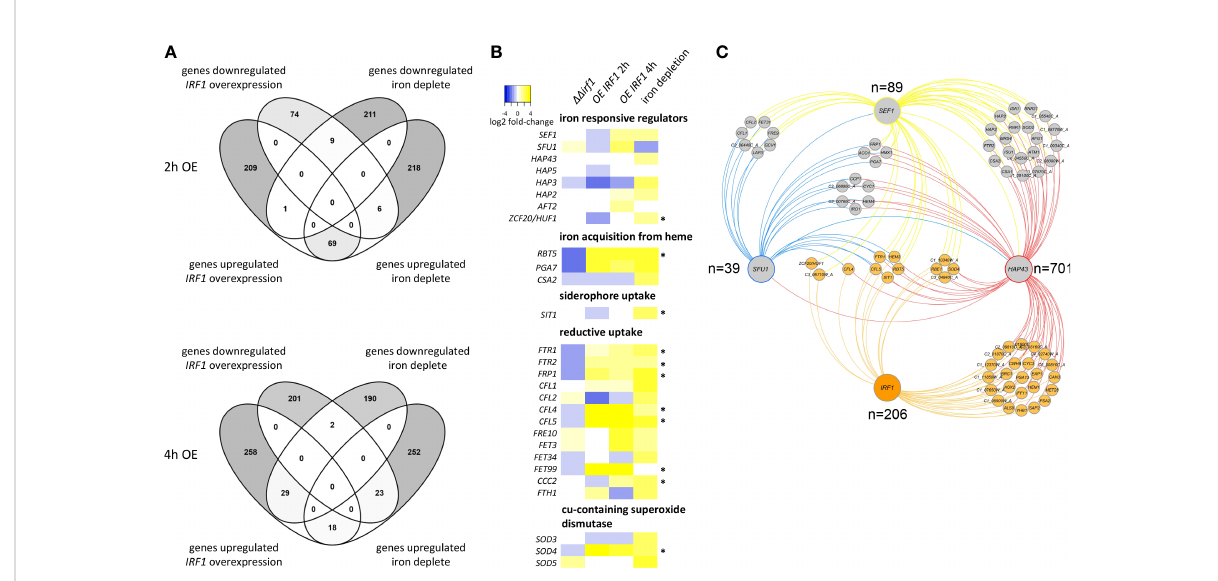
FIGURE 4 Comparative analysis of the IRF1 transcriptome with the iron de fi ciency transcriptome. (A) Transcriptome data of C . albicans cells incubated under iron de fi ciency were taken from Lan et al. (2004) and compared with the transcriptome data of C. albicans overexpressing IRF1 after 2 hours (upper panel) and after 4 hours (lower panel). (B) Heatmap of expression differences (log2 fold-changes) of genes involved in iron homeostasis. (* indicates that the gene is a direct target of Irf1). (C) Interaction network of transcriptional regulators involved in maintaining iron homeostasis. The corresponding target genes of the respective transcription factors were obtained from pathoyeastract (http://pathoyeastract. org/) and graphically displayed with Cytoscape (Shannon et al.,